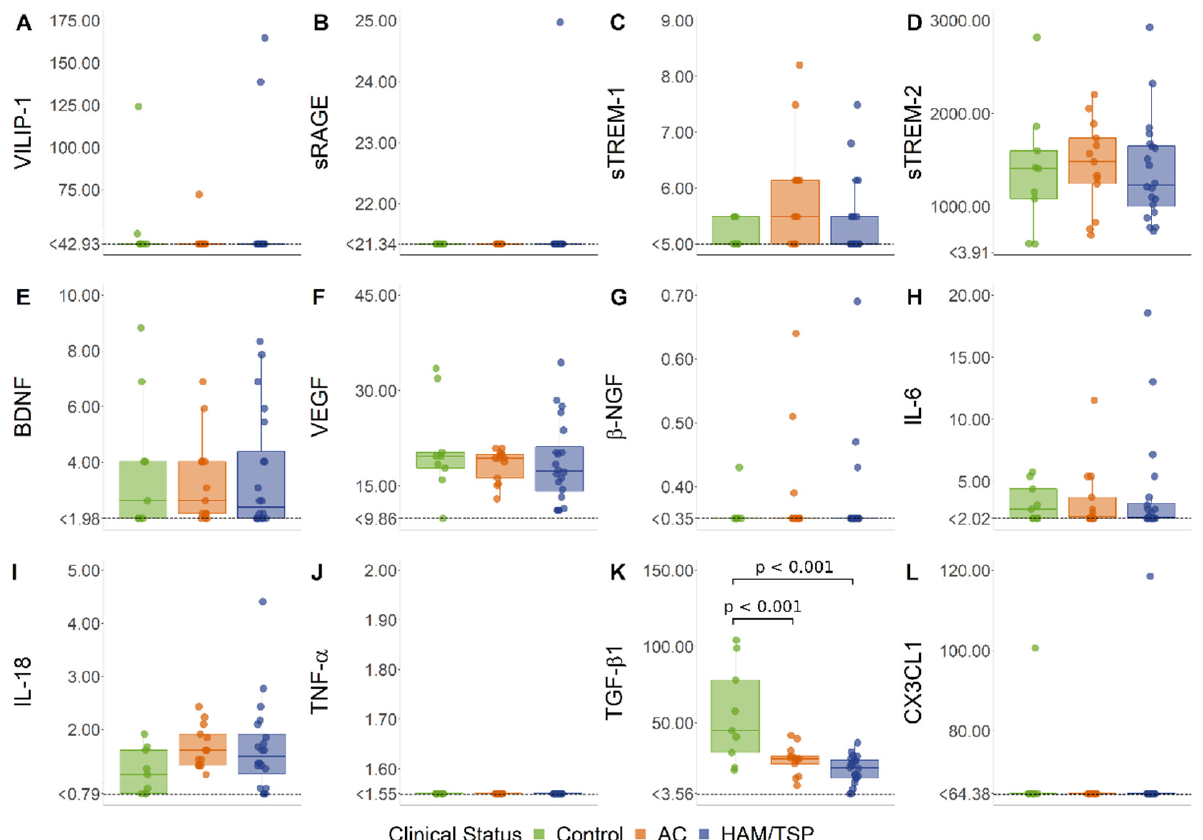
Figure 4 . CSF levels of factors associated with neuroinflammation. ( A ) VILIP-1, ( B ) sRAGE, ( C ) sTREM-1, ( D ) sTREM-2, ( E ) BDNF, ( F ) VEGF, ( G ) β -NGF, ( H ) IL-6, ( I ) IL-18, ( J ) TNF- α , ( K ) TGF- β 1, and ( L ) fractalkine (CX3CL1) levels were simultaneously determined with a multiplex bead-based immunoassay by flow cytometry in cerebrospinal fluid (CSF) samples from asymptomatic HTLV-1